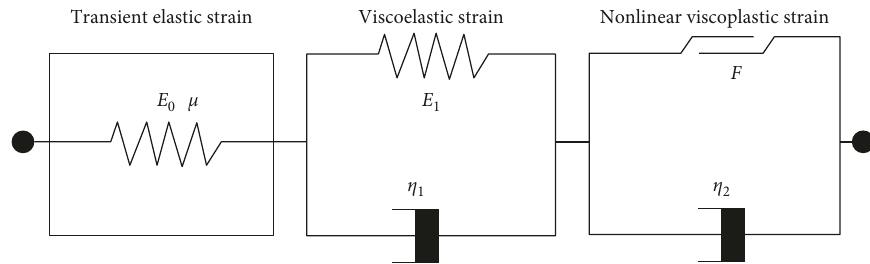
Figure 1: Coupled creep damaged constitutive model of artificial frozen